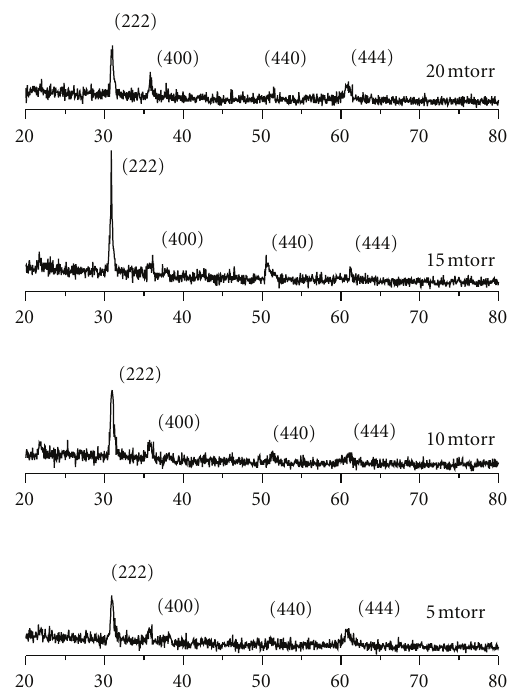
Figure 2: XRD patterns of the ITiO films deposited at di ff erent gas pressures.